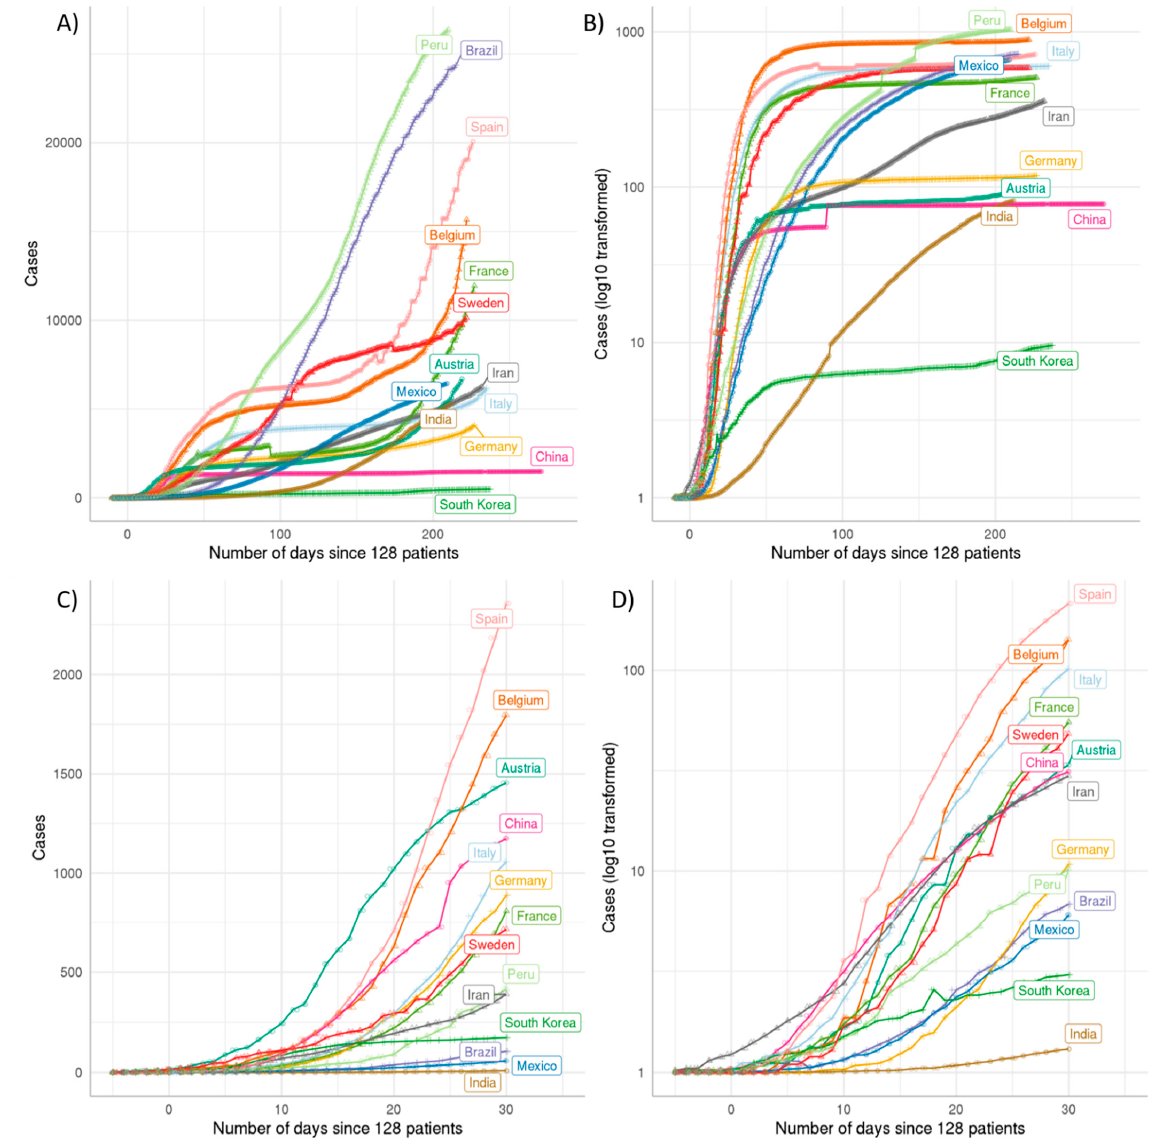
Figure 2. Cumulative cases per million population. ( A ) Cumulative patient numbers divided by the population in million illustrate the respective epidemic situation. ( B ) Cumulative death numbers should avoid biases coming from different diagnostic capabilities and standards. ( C ) Cumulative patient cases per million population up to day 30, ( D ) Cumulative death cases per million population up to day 30. For China the data of Hubei province were analyzed as here full data were available and infection spread was successfully nearly completely limited to this region. The figure was generated by us using the data obtained from RKI/Tencent with a R/nCov2019 script [22].